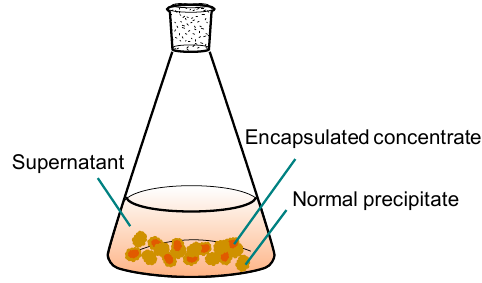
Figure 1. Schematic diagram of the coating phenomenon.